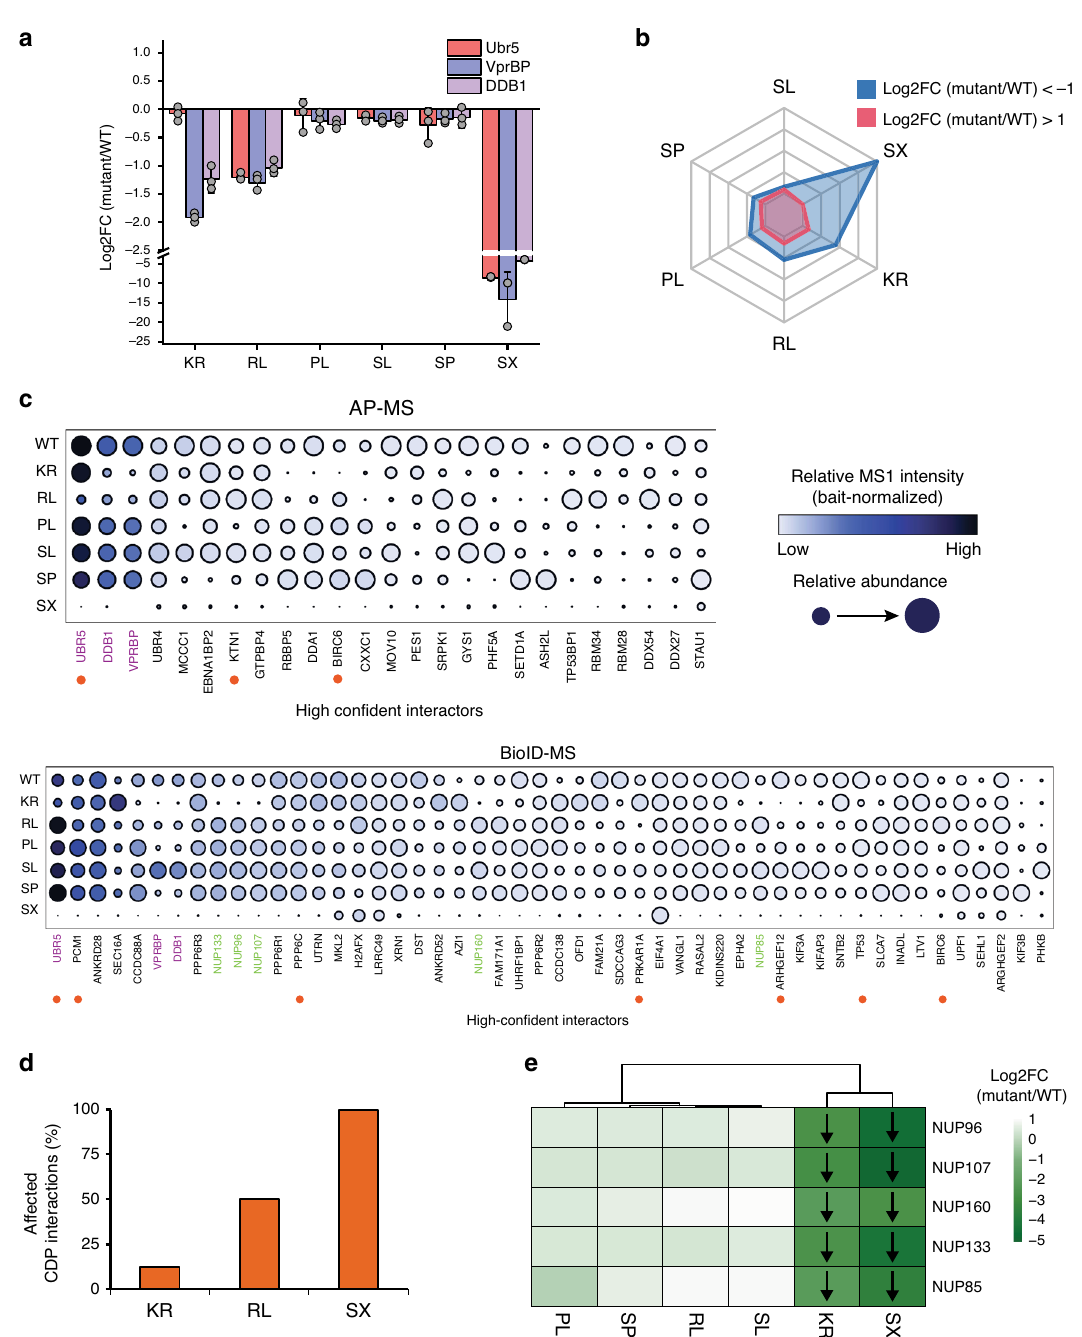
Fig. 4 Cancer-related point mutations perturb the Dyrk2 interactome. a Effect of cancer-related mutations on the interaction to the core subunits of the Dyrk2 – EDVP complex measured by AP – MS. Error bars denote the mean value (center) with 95% con fi dence interval ( n = 3 biologically independent experiments). b Radar chart representing the number of changed interactors ( │ log2FC │ > 1) measured by AP – MS and BioID – MS. c Mutation perturbed Dyrk2 interactome measured by AP – MS (upper panel) or BioID – MS (lower panel). The color indicates the bait (Dyrk2) normalized MS1 intensity. The node size displays the relative abundance of an interactor across the mutant conditions. Dyrk2 – EDVP subunits are highlighted in purple letters, nuclear Y- complex subunits are highlighted in green letters. Cancer driver proteins (CDPs) are marked with a red dot. d Effect of Dyrk2 mutants on the interaction with cancer driver proteins (CDPs) ( │ log2FC │ > 1, adj. p -value ≤ 0.05). Dyrk2 SL, SP, and PL do not affect CDP interactions. e Certain point mutations affect the binding of Dyrk2 to the Y-complex of the nuclear pore. The arrow indicates the direction of a signi fi cant change in binding (adj. p -value ≤ 0.05). Statistical analysis was performed with two-tailed unpaired Student ’ s t -test and p -values were adjusted using the method of Benjamini – Hochberg 67 . Source data are provided as source data fi